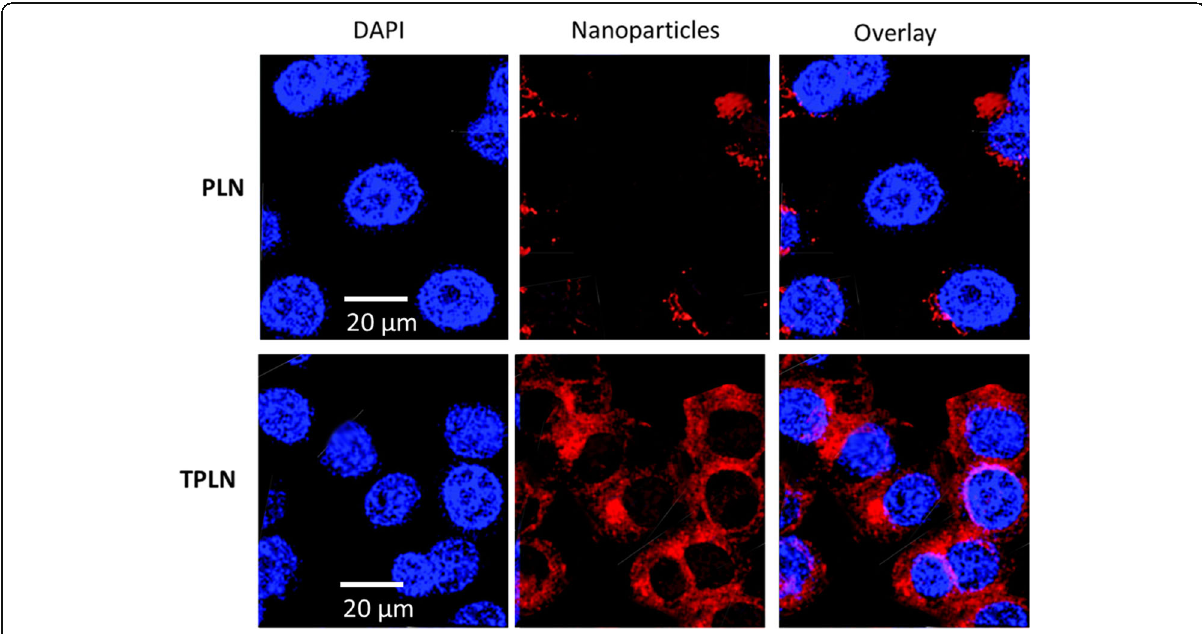
Fig. 4 Cellular uptake analysis of TPLN and PLN using confocal laser scanning microscope (CLSM) at 37 °C. Rhodamine B was used as a fluorescent dye and incubated for 3 h. The cellular uptake analysis was performed after incubating the nanoparticles for 3 h under 37 °C in incubator. Scale